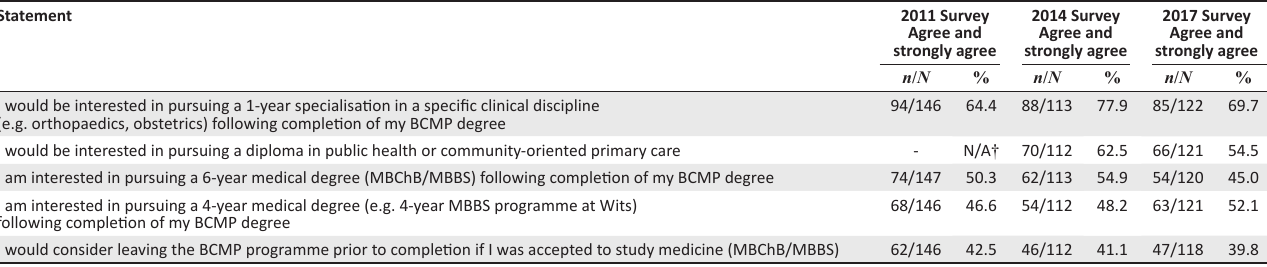
TABLE 6: Bachelor of Clinical Medical Practice students’ interest in pursuing further training.